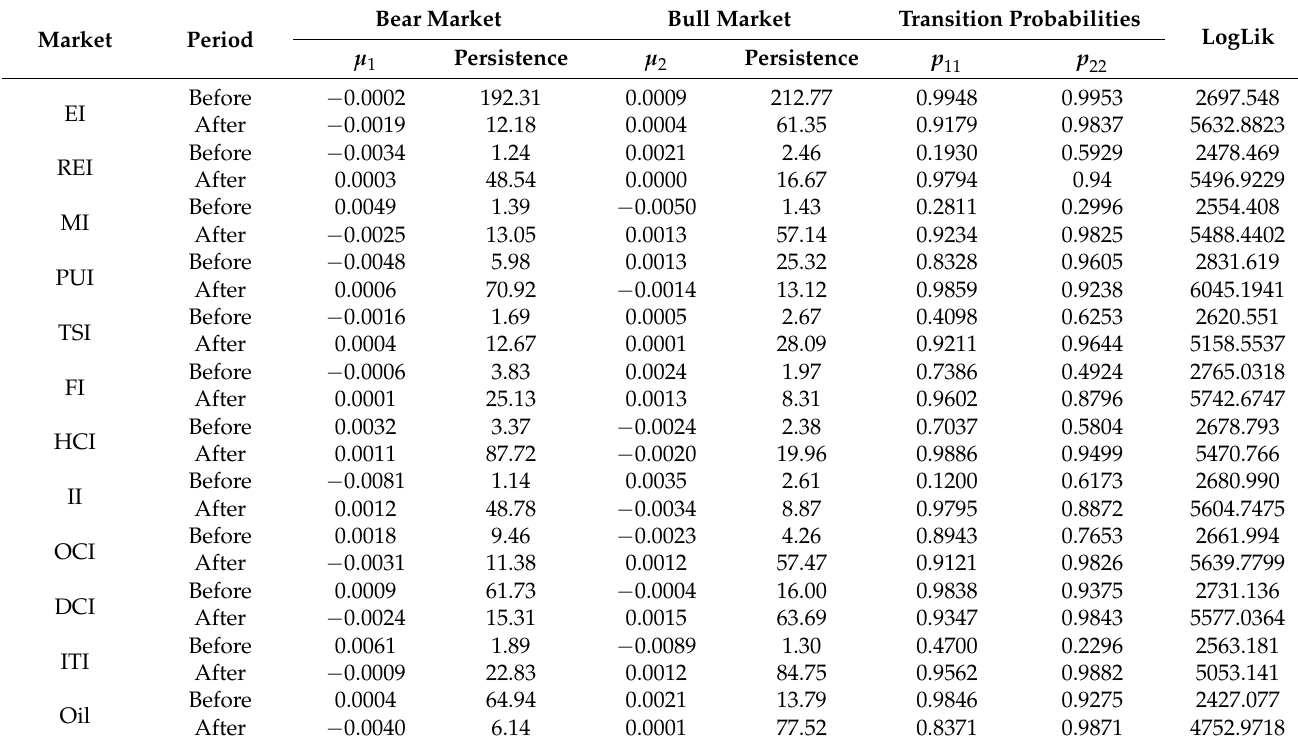
Table 4. Estimates for Markov regime switching